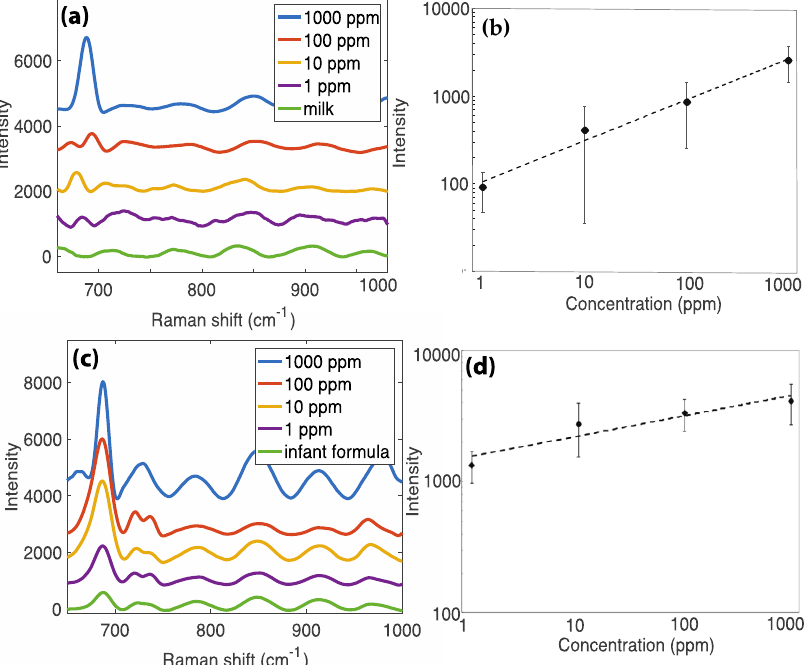
Figure 5. SERS detection of melamine in milk and infant formula. ( a ) The SERS spectra of melamine in milk. The key peak at 686–703 cm − 1 was used for identification and quantification. ( b ) Log–log plot for calibration of melamine concentration in milk. Points represent an average of n = 5 spectra. Linear regression yields y = 106.41 x 0.4656 , with an R² value of 0.9828. ( c ) The SERS spectra of melamine in infant formula. The key peak at 686–703 cm −1 was used for identification and quantification. ( d ) Log–log plot for calibration of melamine concentration in infant formula. Linear regression yields y = 1555.8 x 0.1544 , with an R² value of 0.8883.